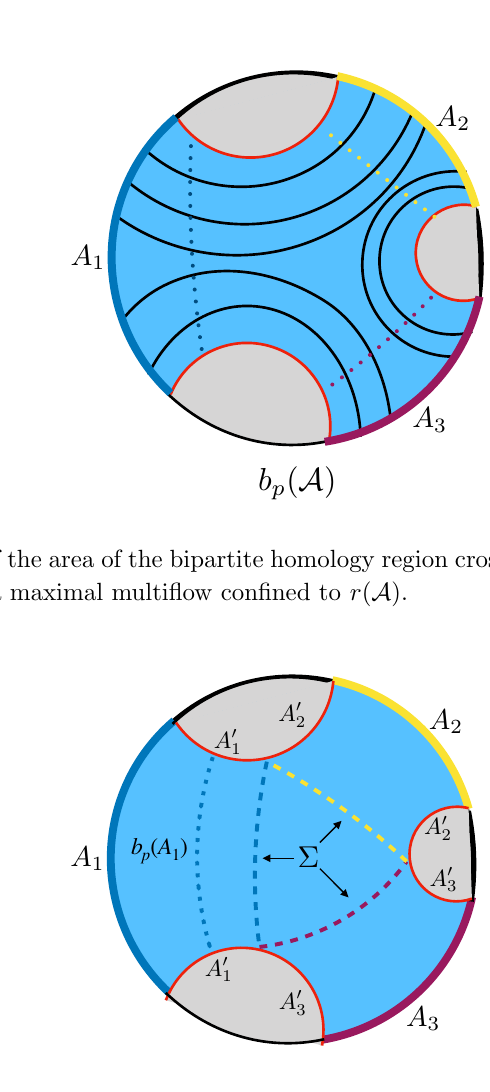
Figure 13 . The surface b p ( A ) is a geometric obstacle to the maximal (cid:13)ow. Additional (cid:13)ux is needed on in order to get (cid:13)ows which saturate on O